Question: Condense the content of this figure into a single sentence.
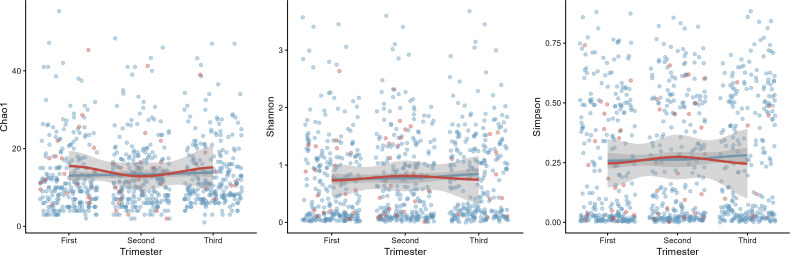
Answer: Demographic and birth characteristics of women in the study (data were given as mean ± SD or n [%])